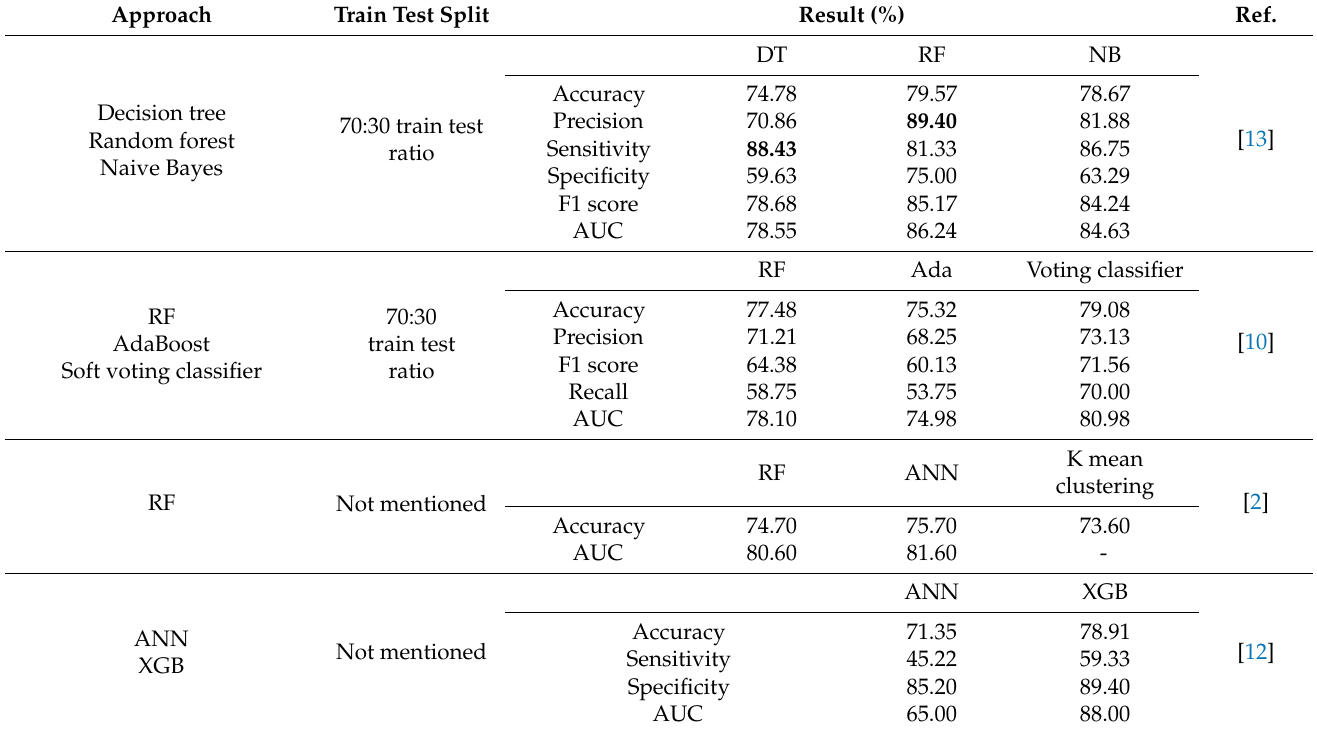
Table 6. Comparison of the diabetes detection model outcomes with the previous